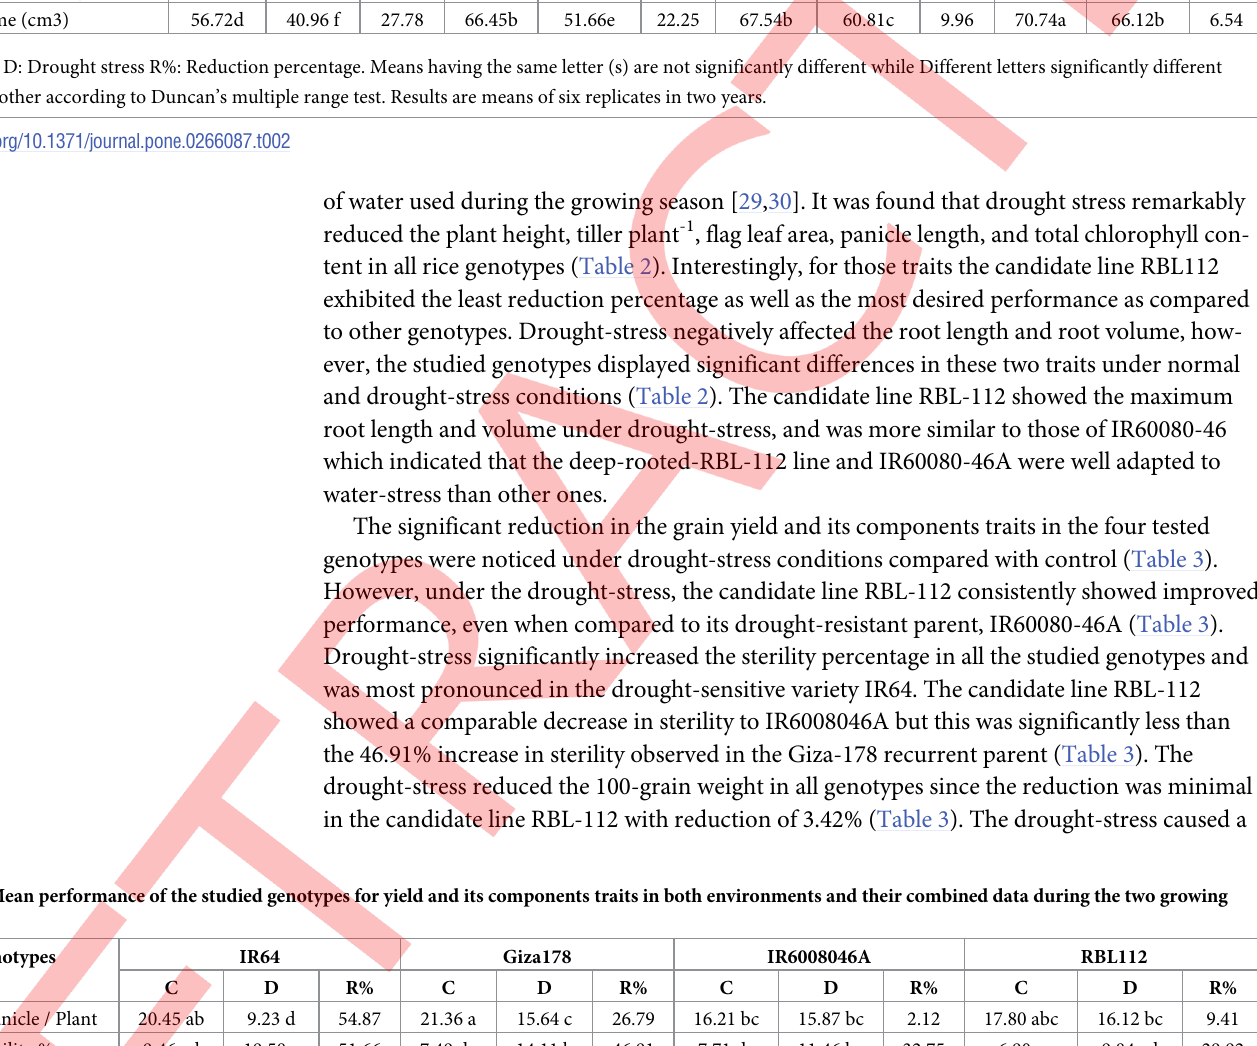
Flag leaf Area Panicle length (cm) Maximum Root Length (cm)